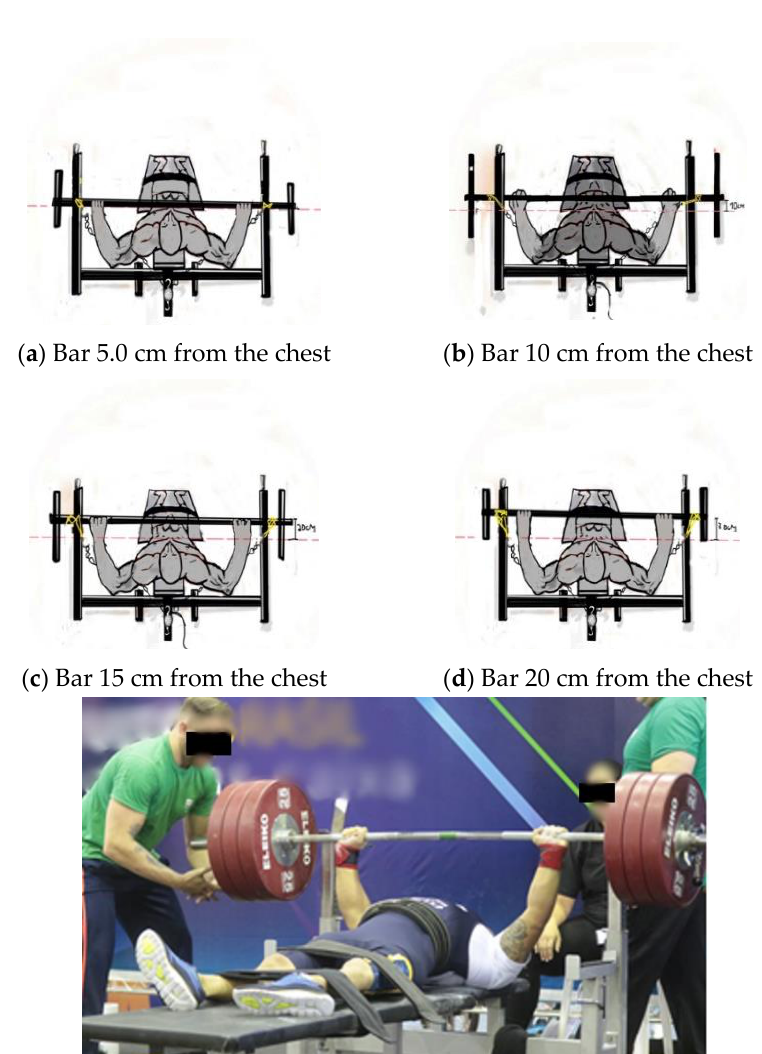
Figure 2. Schematic drawing with the different heights ( a – d ) of the bar to the chest and ( e ) photo of the athlete’s position on the bench in competition.